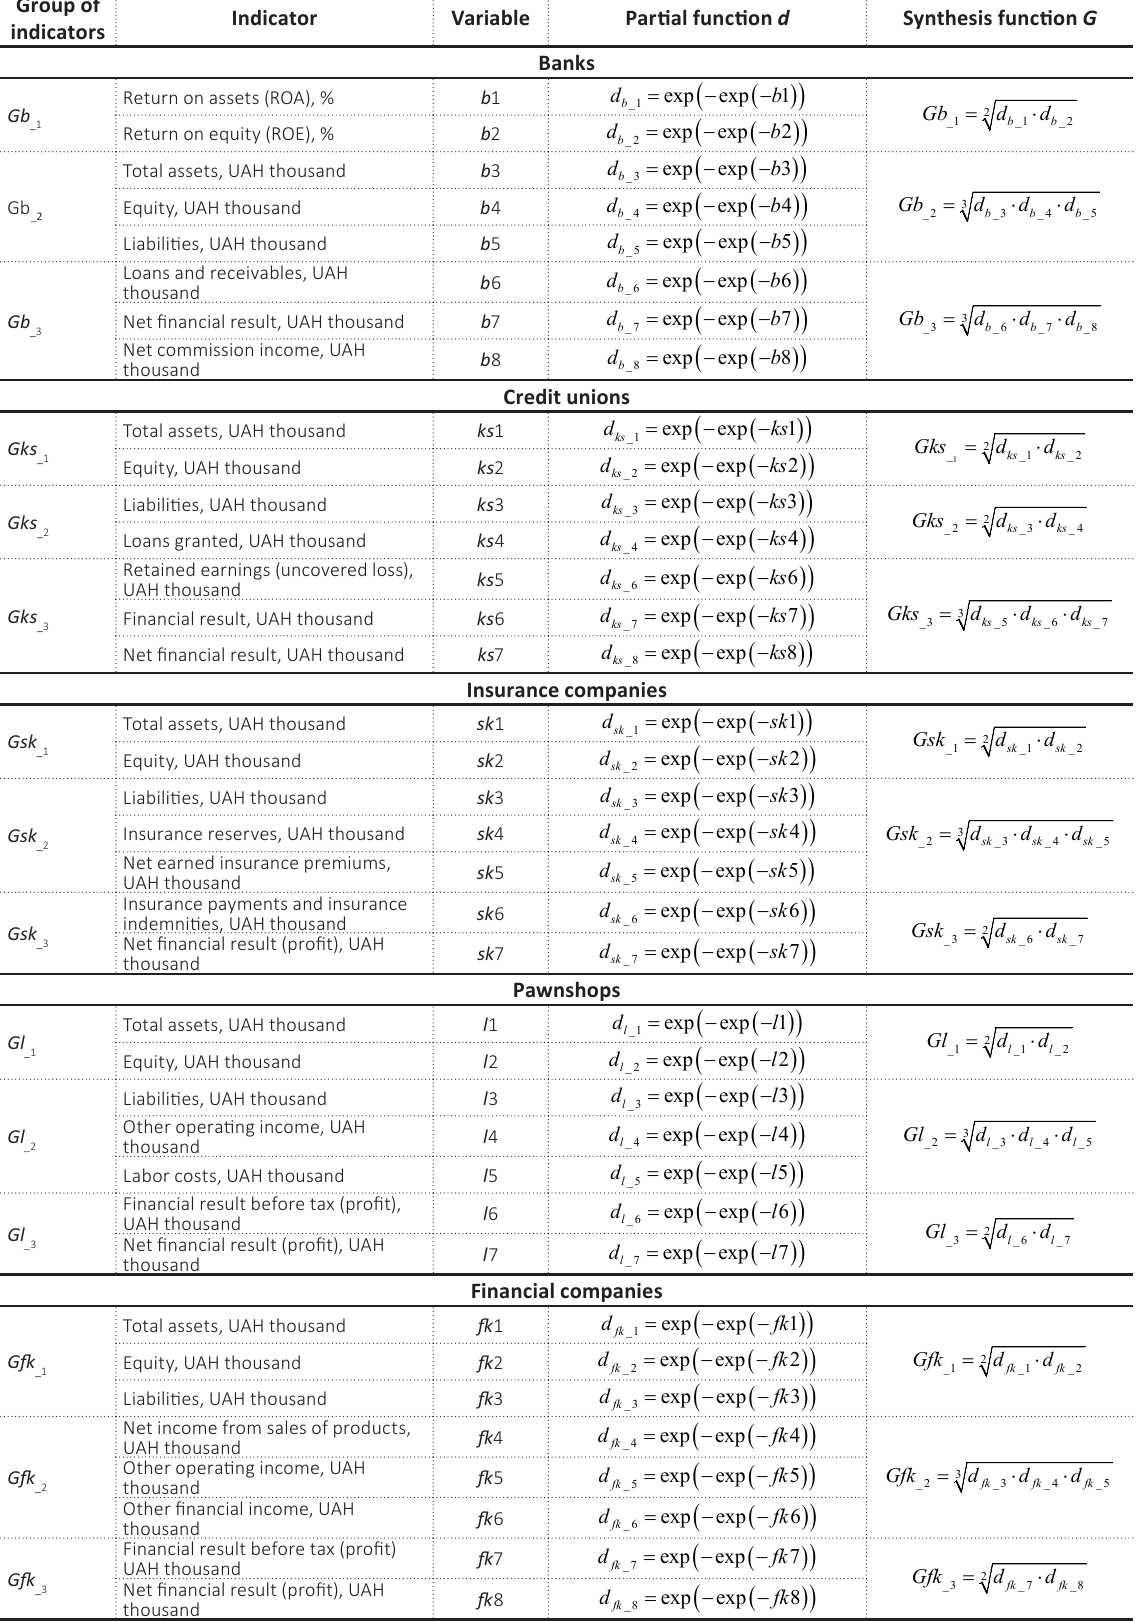
Table 3. Description of intermediate model